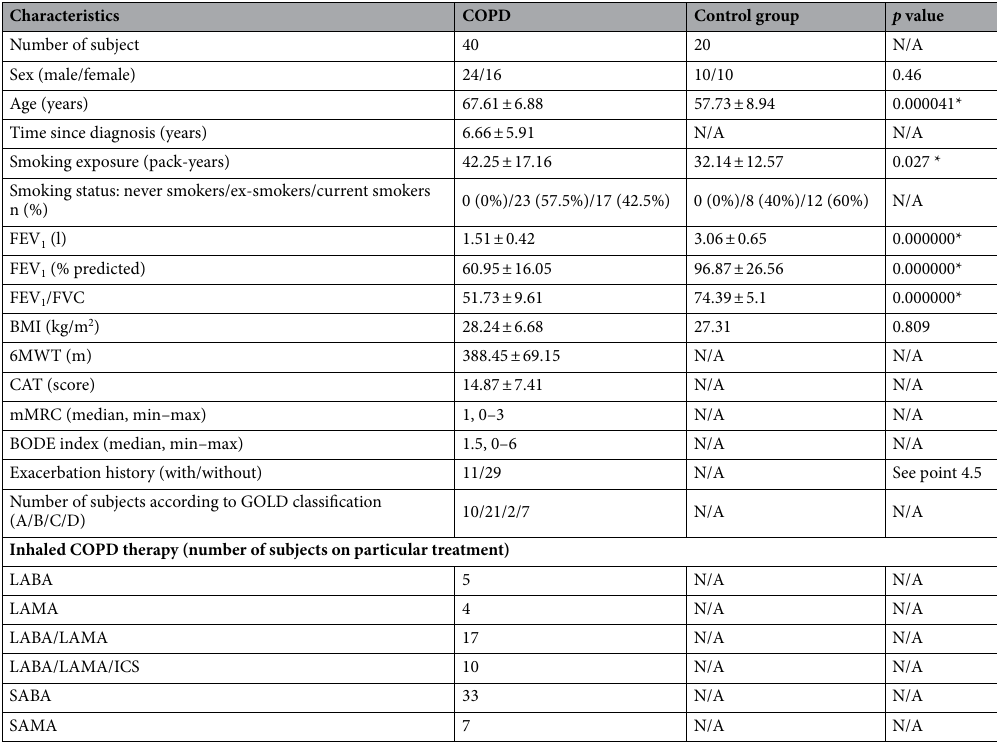
Table 1. Participants’ characteristics. 6MWT minute walk test, BMI body mass index, BODE BMI, airway obstruction, dyspnoea, exercise capacity, CAT COPD assessment test, COPD chronic obstructive